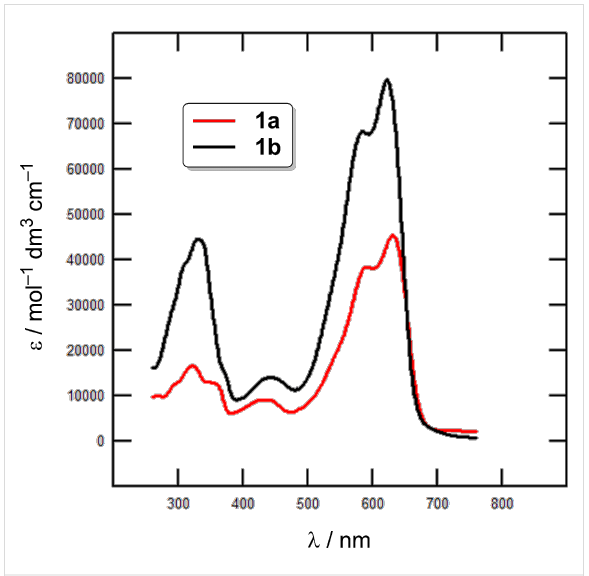
Figure 4: UV–vis absorption spectra of chromophores 1a and 1b in 1,4-dioxane at a concentration of 1 × 10 − 5 M.